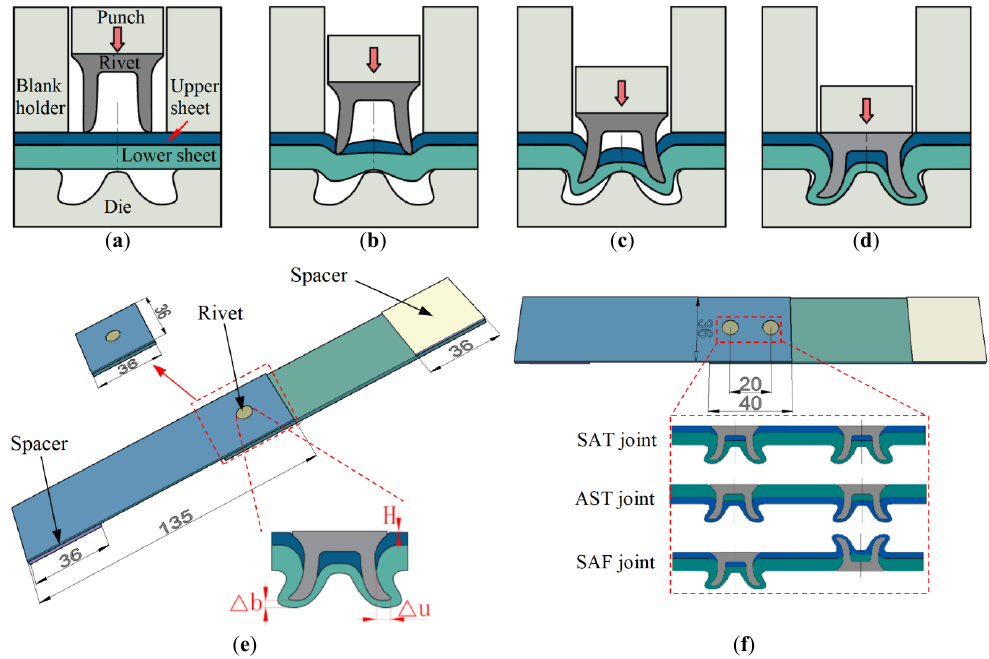
Figure 2. Forming process and geometry sizes of the SPR specimen. ( a ) Clamping; ( b ) puncture; ( c ) expansion; ( d ) forming; ( e ) single-rivet joint; ( f ) two-rivet joint (unit: mm).